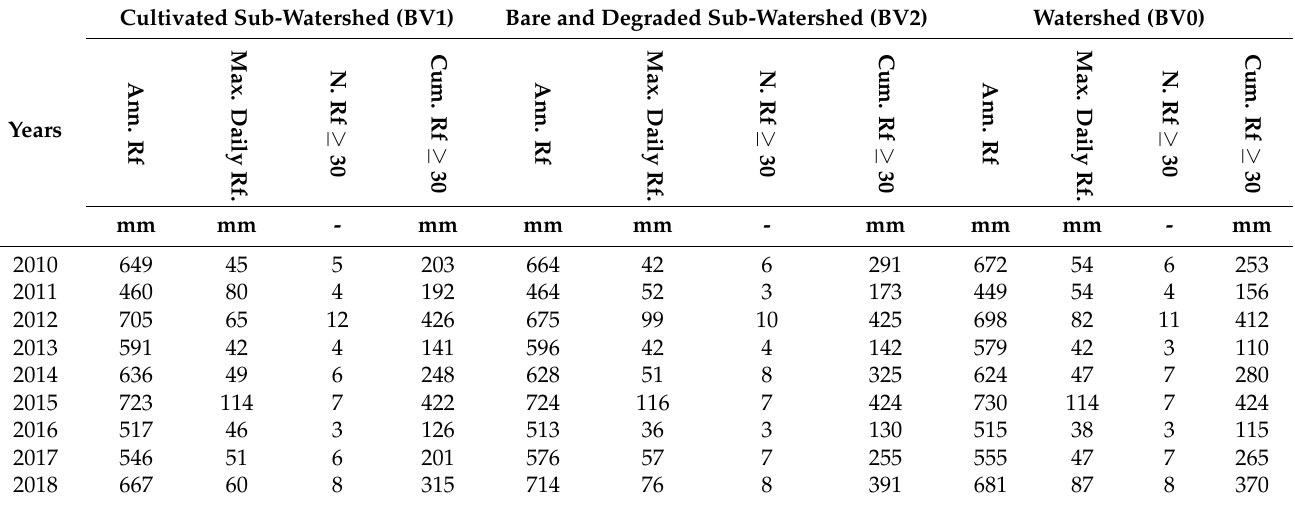
Table 3. Rainfall event description over the monitoring period 2010–2018 in the Tougou